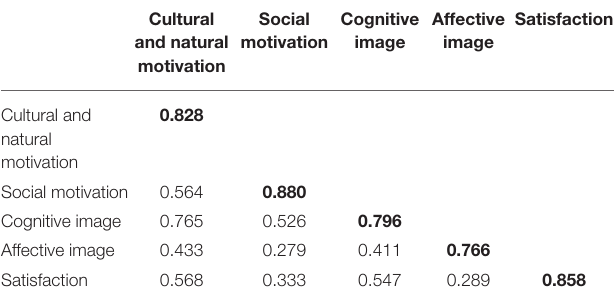
TABLE 7 | Correlation and square root of AVE for first order latent variables.